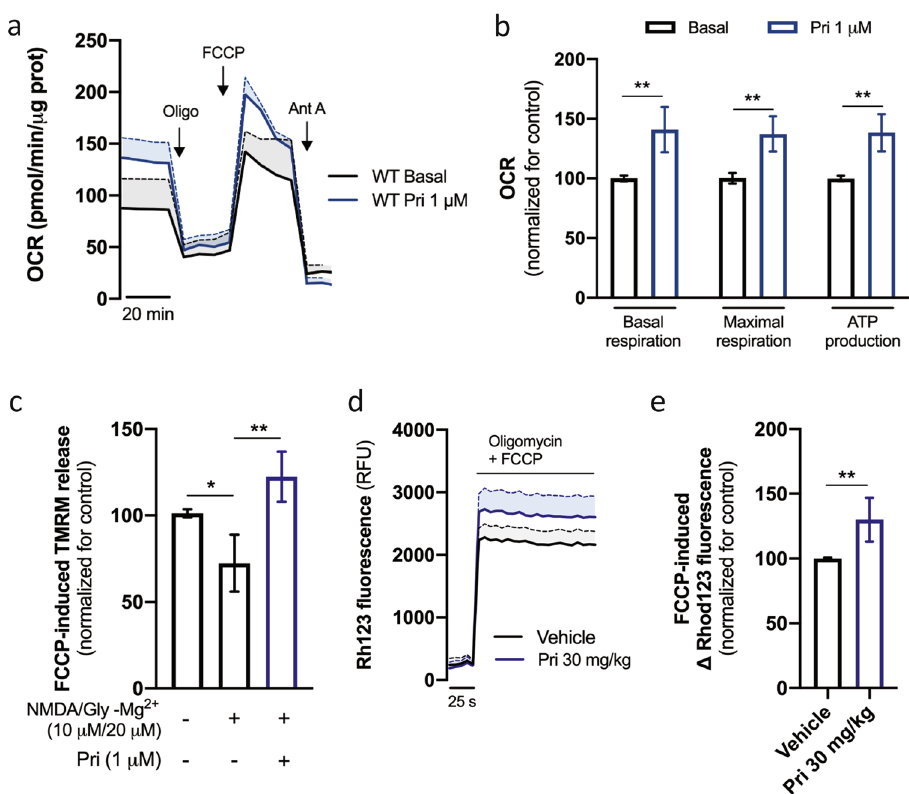
Figure 5. Pridopidine increases neuronal mitochondrial function. Striatal neurons were treated with 1 µM pridopidine for 24 h and OCR (oxygen consumption rate) was measured by Seahorse analyzer ( a ). Graph shows time-dependent changes in O 2 levels (n = 6). ( b ) Quantification of OCR rate. ( c ) Striatal neurons were treated, when indicated, with 1 µM pridopidine for 24 h. 6 h before the experiment neurons were acutely stimulated, when indicated, with NMDA (10 µM) plus glycine (20 µM) for 15 min. TMRM fluorescence was recorded after complete mitochondrial membrane depolarization (n = 5). Mitochondrial membrane potential was measured in isolated striatal mitochondria using Rhodamine123 ( d ) and quantified ( e ). Graph shows time-dependent changes in fluorescence after adding oligomycin + FCCP (n = 6). Data are the mean ± SEM. All experiments were run in triplicates. *p < 0.05, **p < 0.01 by non-parametric Kruskal–Wallis test or Mann–Whitney test (in e